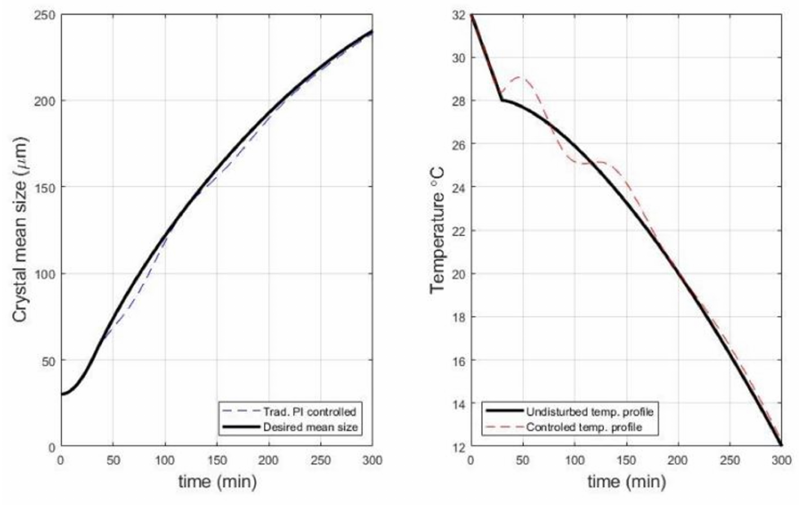
Figure 3. Comparison of undisturbed and disturbed case scenarios for the application of the Moving Window methodology to the RBF soft sensor and a traditional PI